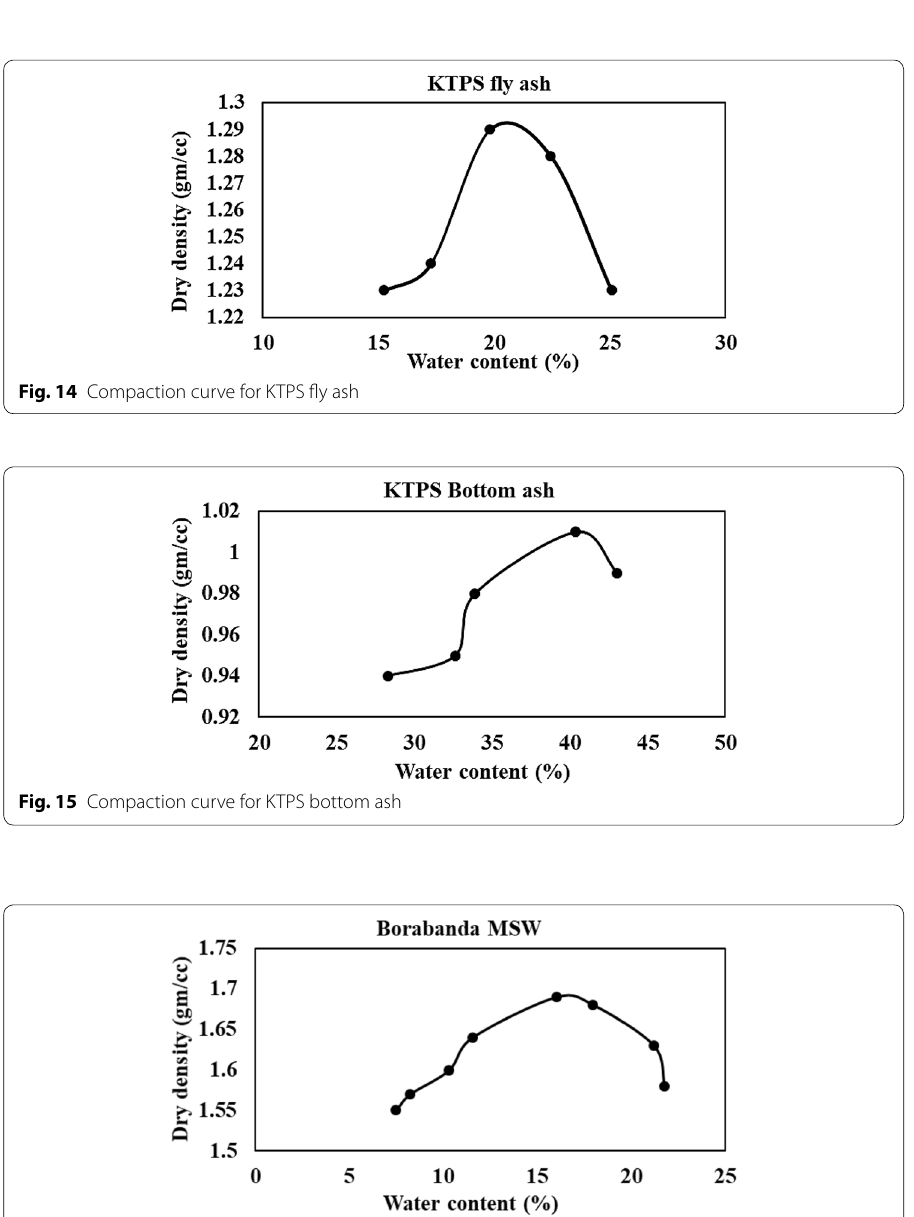
Fig. 16 Compaction curve for Borabanda